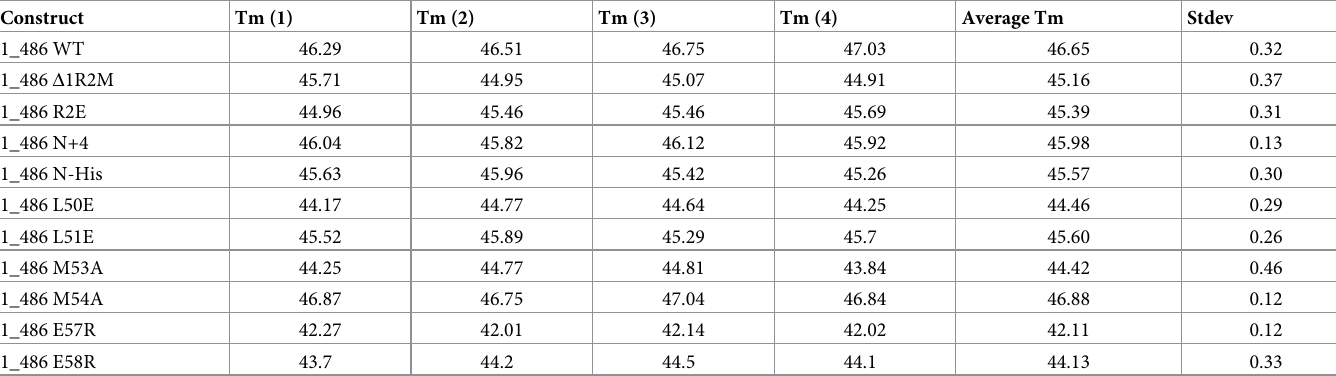
Table 3. Tm values of PRC1 1–486 and its mutants.